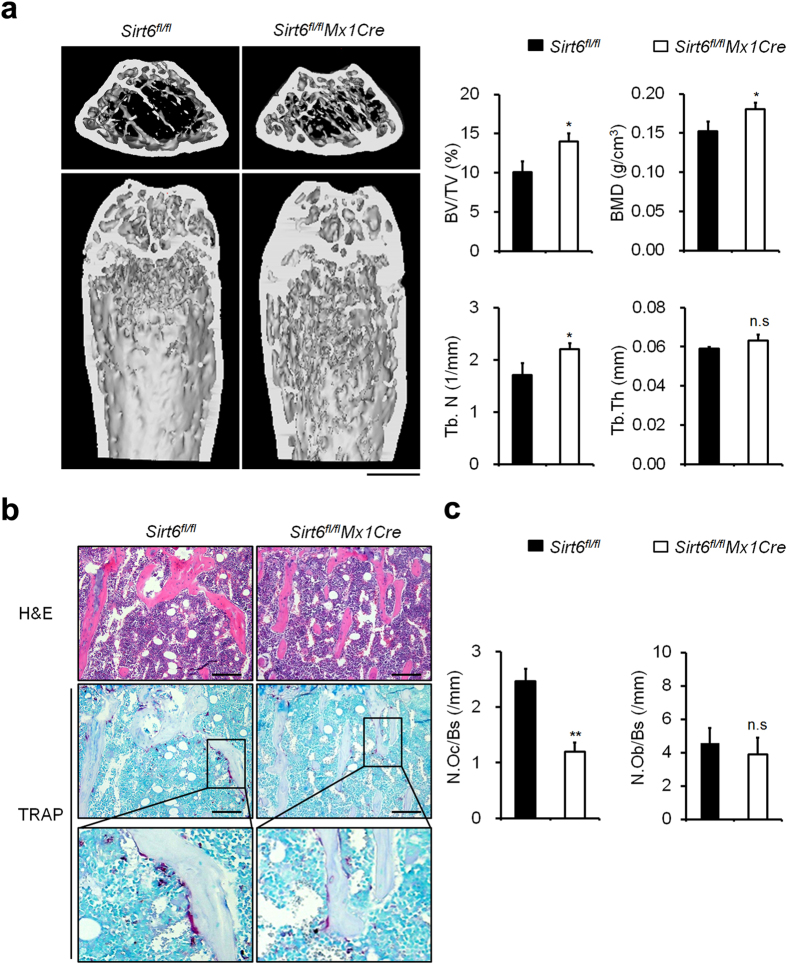
Sirt6 fl/flMx1Cre mice exhibited a high bone mass phenotype.(a) Microcomputed tomography (μCT) analysis of the femurs of 16-week-old Sirt6fl/fl(n = 5) and Sirt6fl/flMx1Cre (n = 5) male mice. BV/TV, bone volume per tissue volume; Tb.N, trabecular number; BMD, bone mineral density; Tb.Th, trabecular thickness. Scale bar, 1 mm. **P < 0.01. (b) Histological analysis of the femurs from 16-week-old Sirt6fl/fland Sirt6fl/flMx1Cre mice. Histology sections were stained with hematoxylin and eosin (upper) and TRAP (middle). Magnified images of the boxed area are shown (bottom). Scale bar, 50 μm. (c) Quantitative histological analysis of parameters in Sirt6fl/fland Sirt6fl/flMx1Cre mice (n = 5); N.Oc/BS, osteoclast number per bone surface; N.Ob/BS, osteoblast per bone surface. (a,c) *P < 0.01, **P < 0.05. n.s: not significant. Data are represented as mean ± S.D.